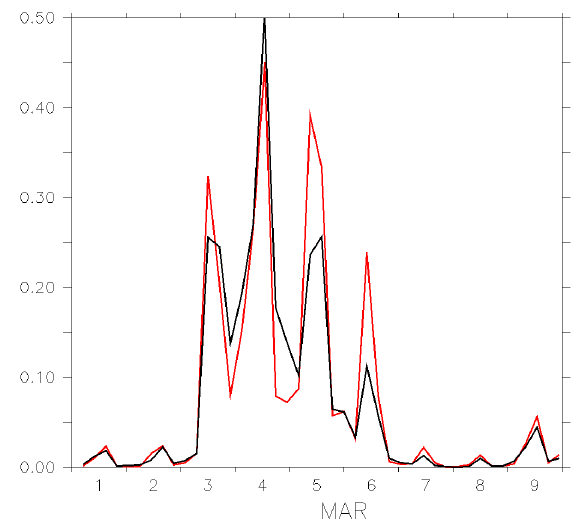
Figure 8. Time series of dust emission (Gg) in the EMAC (black) and in the COSMO/MESSy (red)